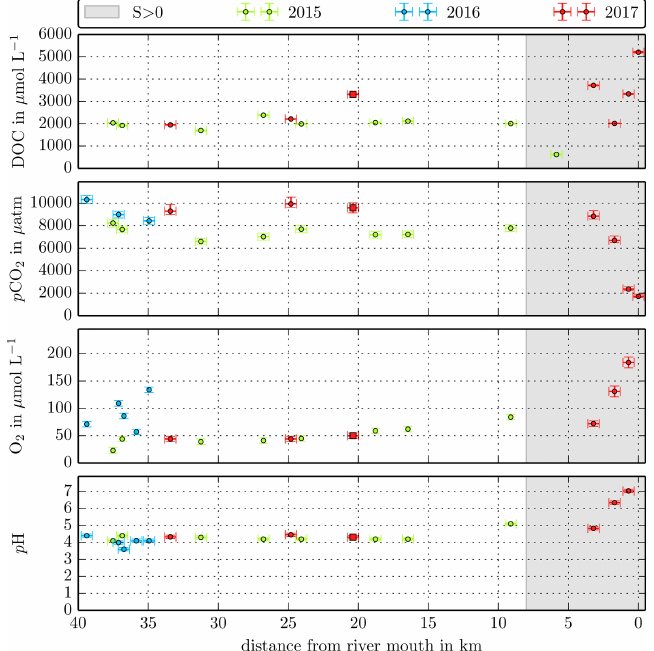
Figure B2. Individual DOC, CO 2 , O 2 , and pH measurements in the Sebuyau River versus the distance from the river mouth. Different colours stand for the individual river campaigns, and the grey shaded area indicates regions of S > 1 that were excluded from the data in this study.